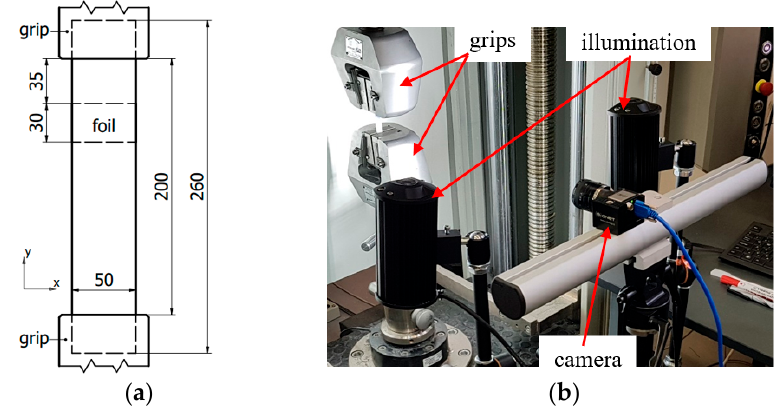
Figure 1. ( a ) Geometry of specimens; ( b ) the experimental setup.